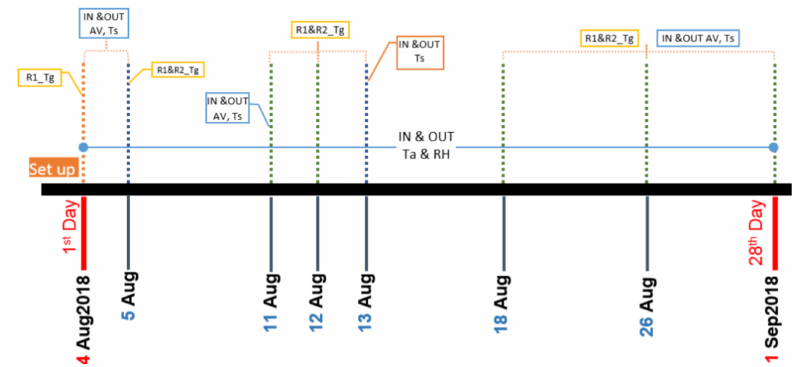
Figure 14. Timeline of the